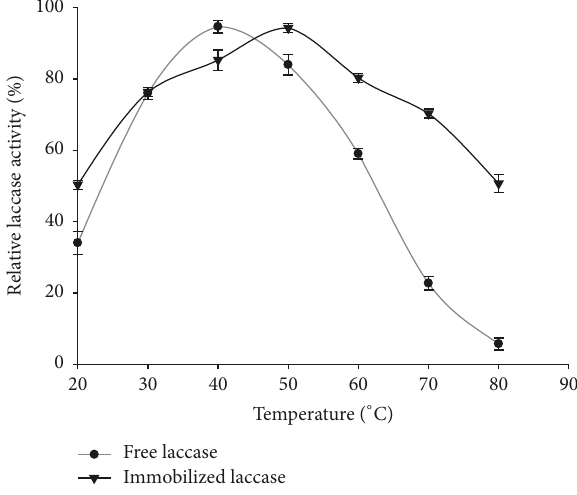
Figure 7: Effect of temperature on enzyme activity in comparison of immobilized laccase with free laccase.